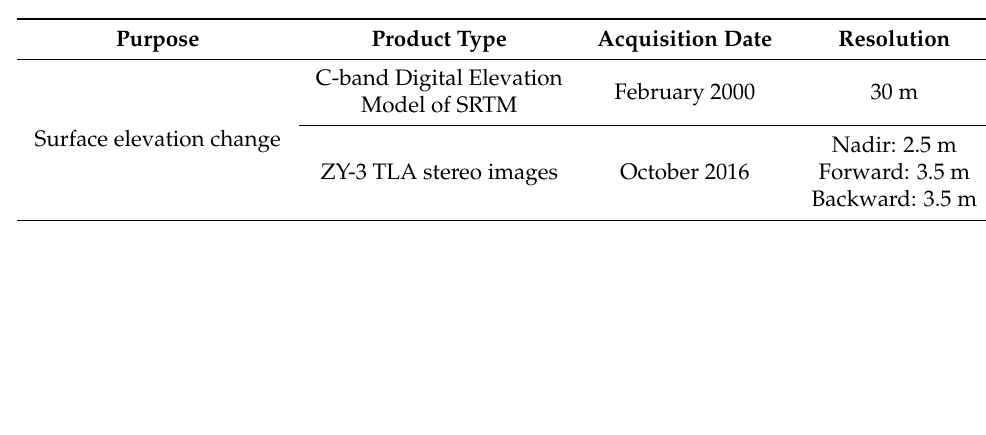
Table 2. Datasets and the relevant information used for the Zhuxi